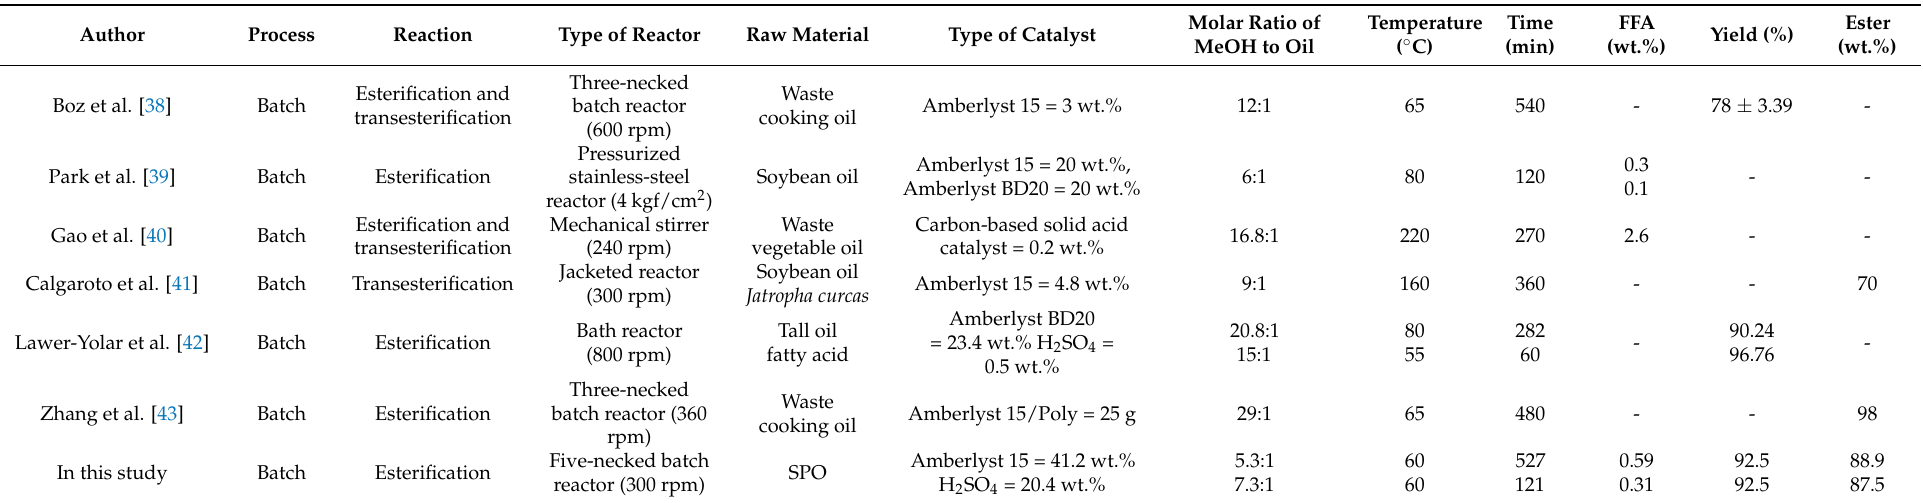
Table 1. Summary of reviews for the biodiesel production process using heterogeneous acid